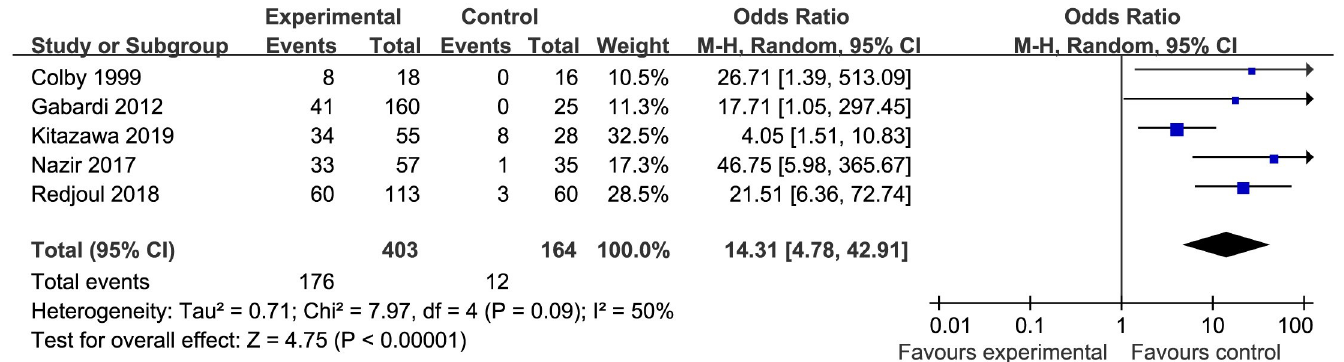
Fig 3. Forest plot of the rate of drug discontinuation. The vertical line indicates no difference between the groups. ORs are represented by diamonds, and 95% CIs are depicted by horizontal lines. Squares indicate point estimates, and the size of each square indicates the weight of the given study in the meta-analysis. M-H, Mantel- Haenszel random-effects